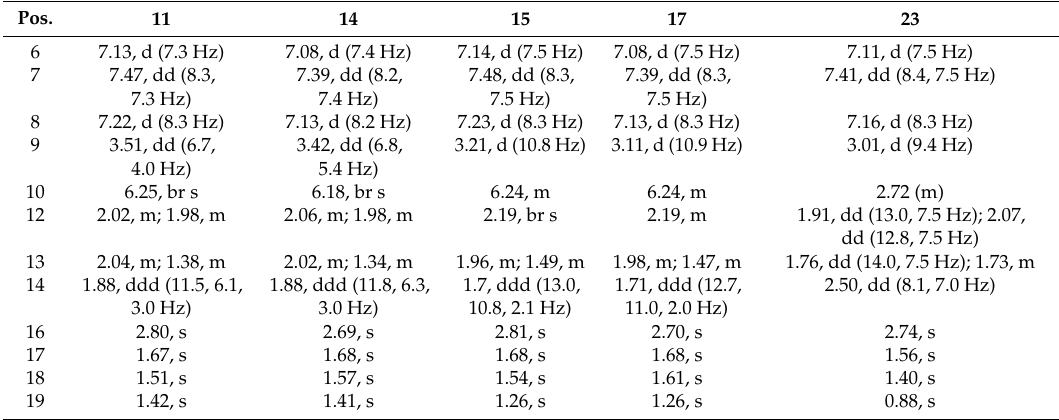
Table 3. 1 H NMR (600 MHz) Spectroscopic Data of 11 , 14 , 15 , 17 , and 23 a